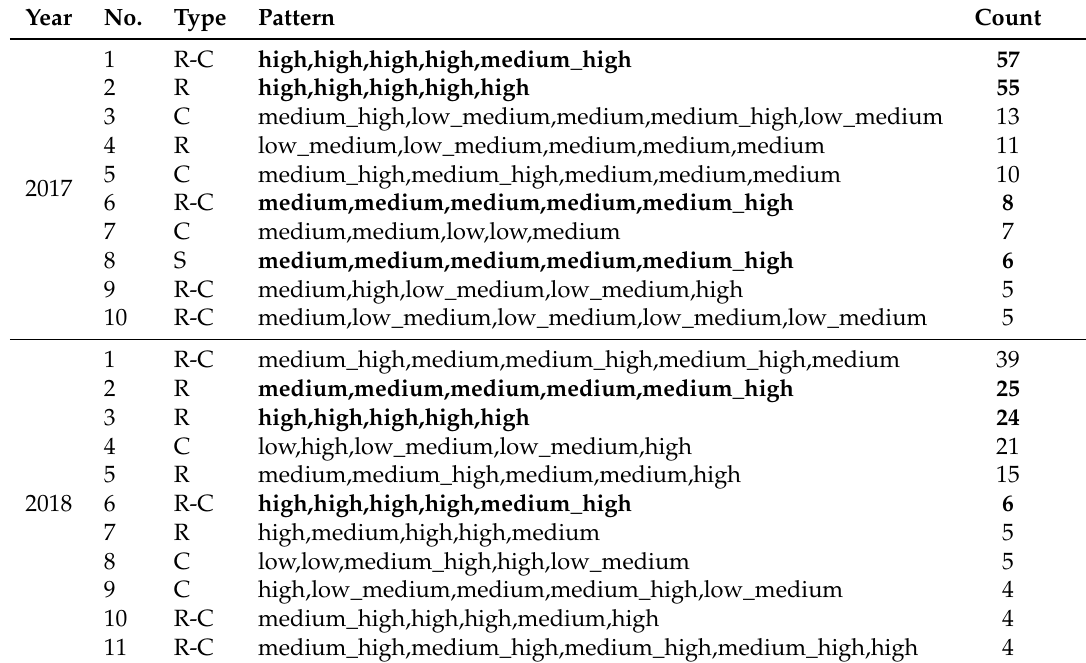
Table 8. Top weekly patterns detected as outliers with respect to building types in 2017 and